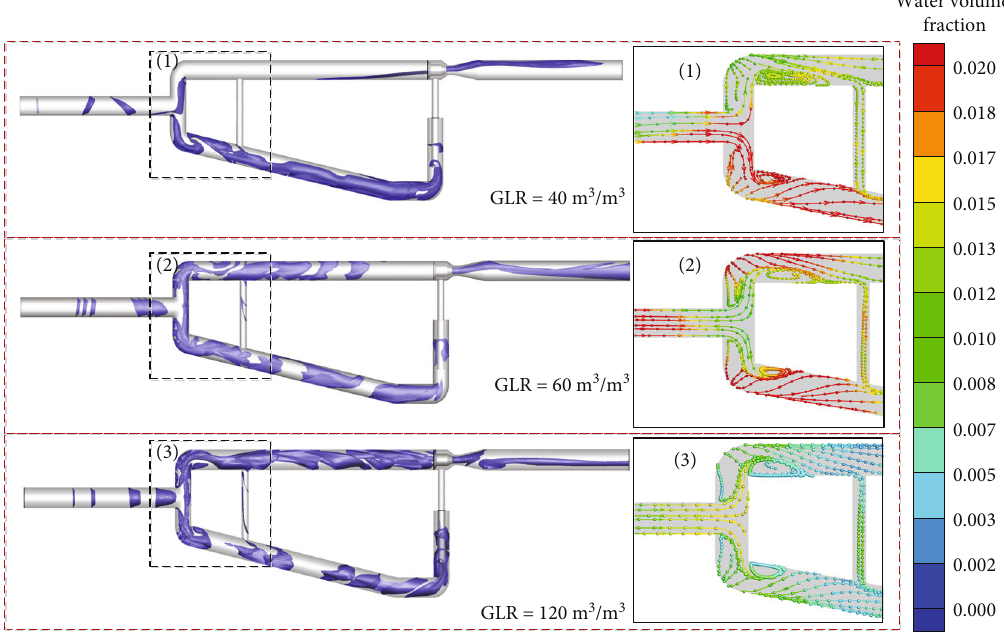
Figure 7: Gas-liquid distribution under di ff erent gas-liquid ratios ( t = 2 : 2s ).